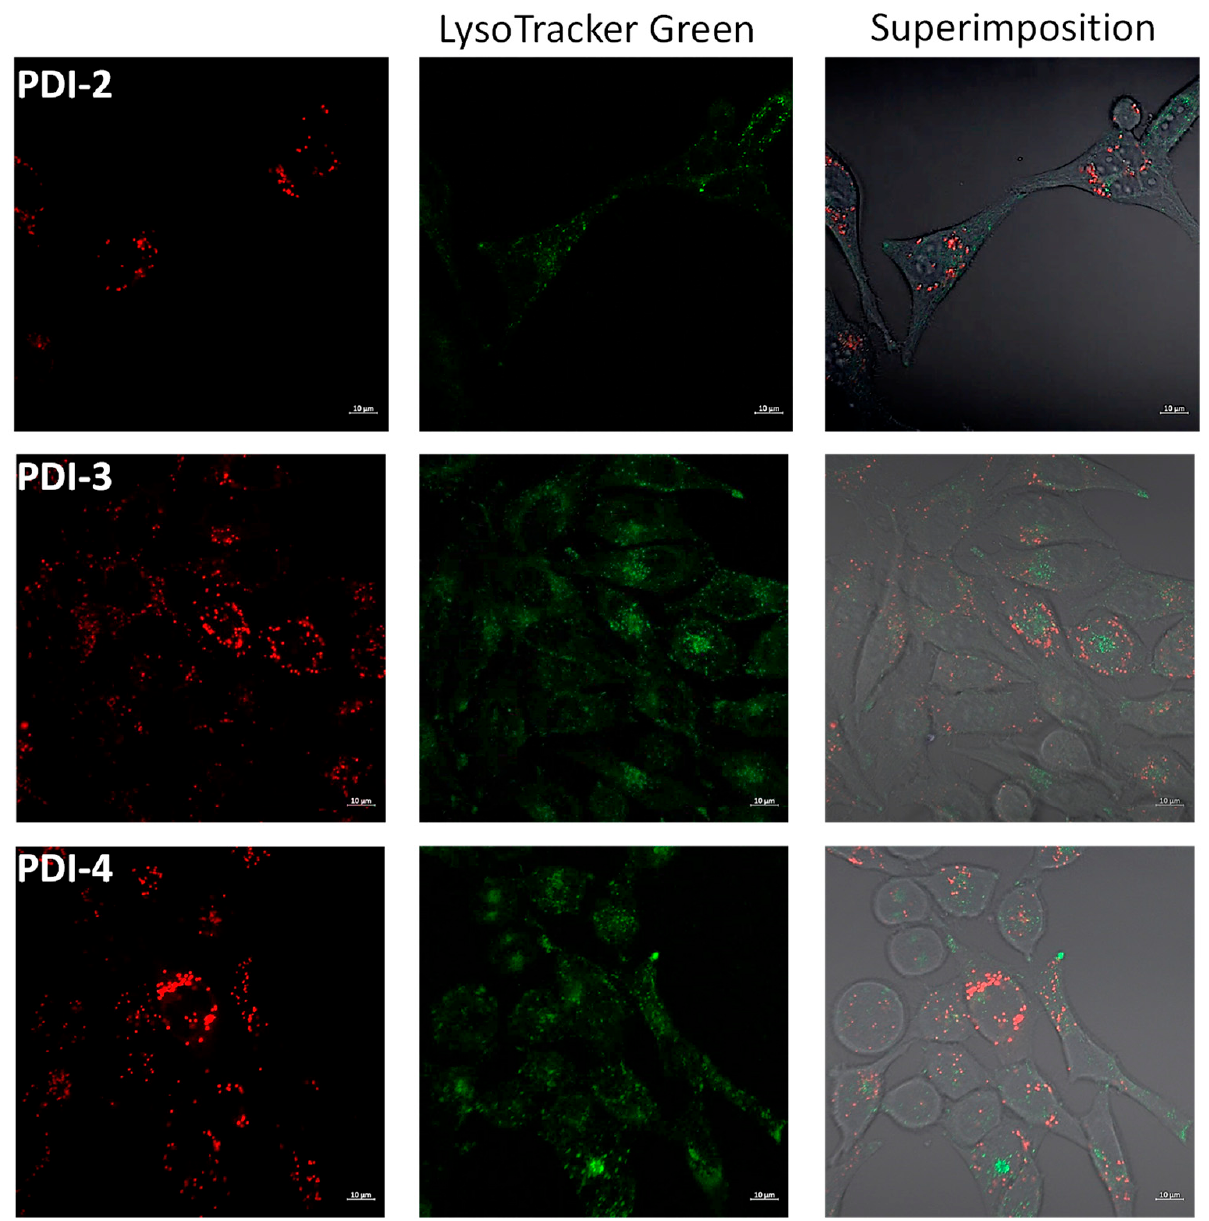
Figure 7. Fluorescence confocal microscopy images in HeLa cells incubated with the ligand PDI-2 and the PDI-3 and PDI-4 complexes at 2 h (red, irradiated at 561 nm) and stained with LysoTracker Green (green, irradiation at 488 nm).